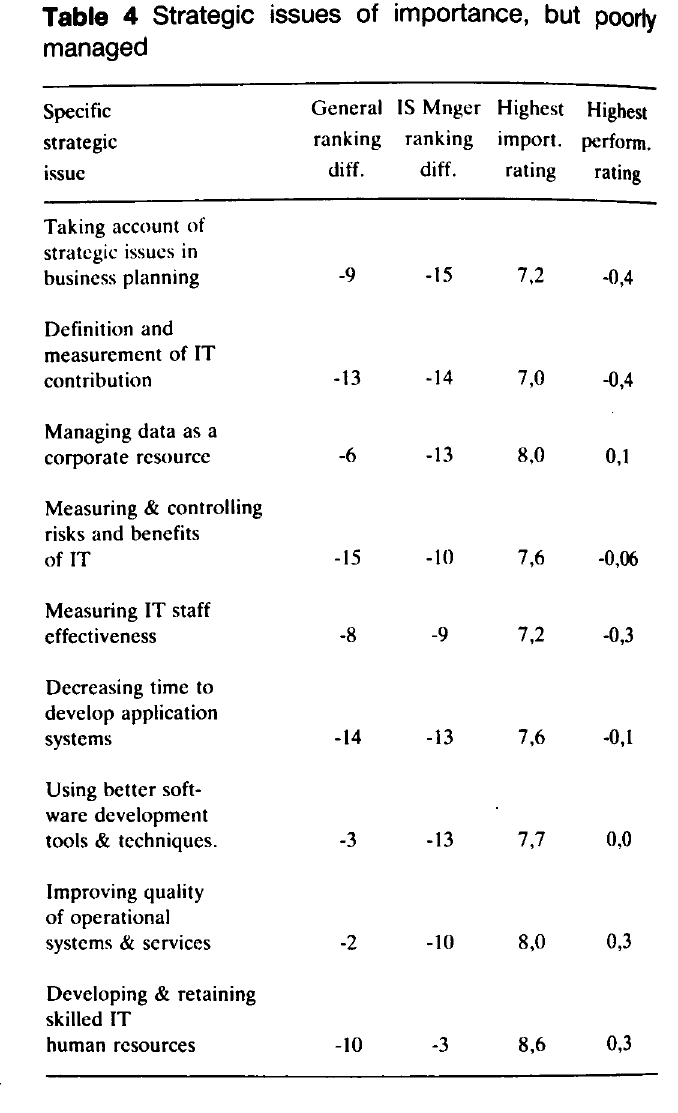
Table 4 Strategic issues of importance, but